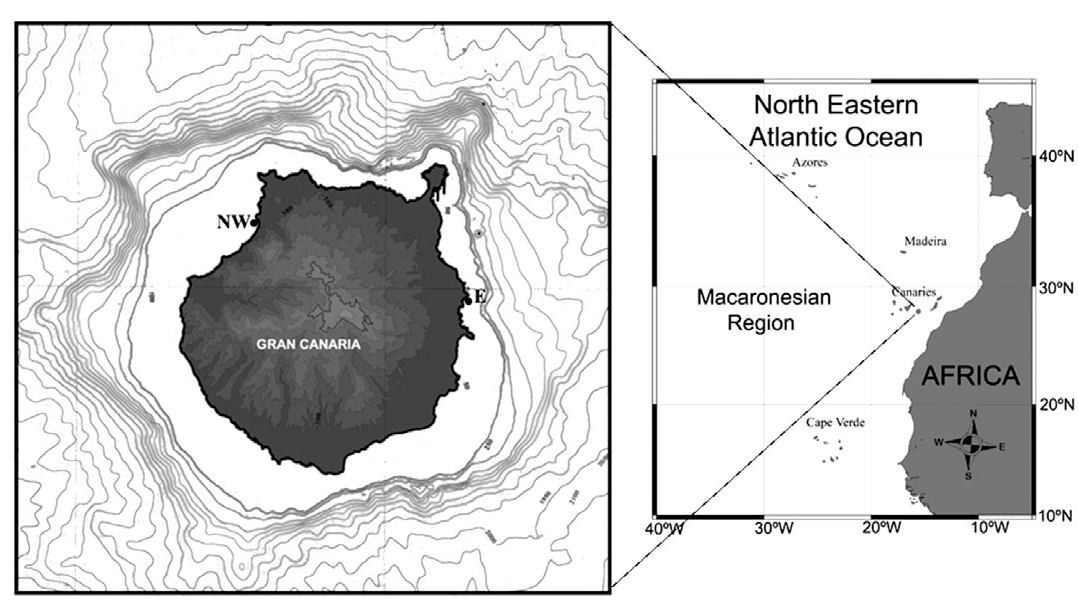
Fig. 1. – Location of study localities at Gran Canary Island (eastern Atlantic